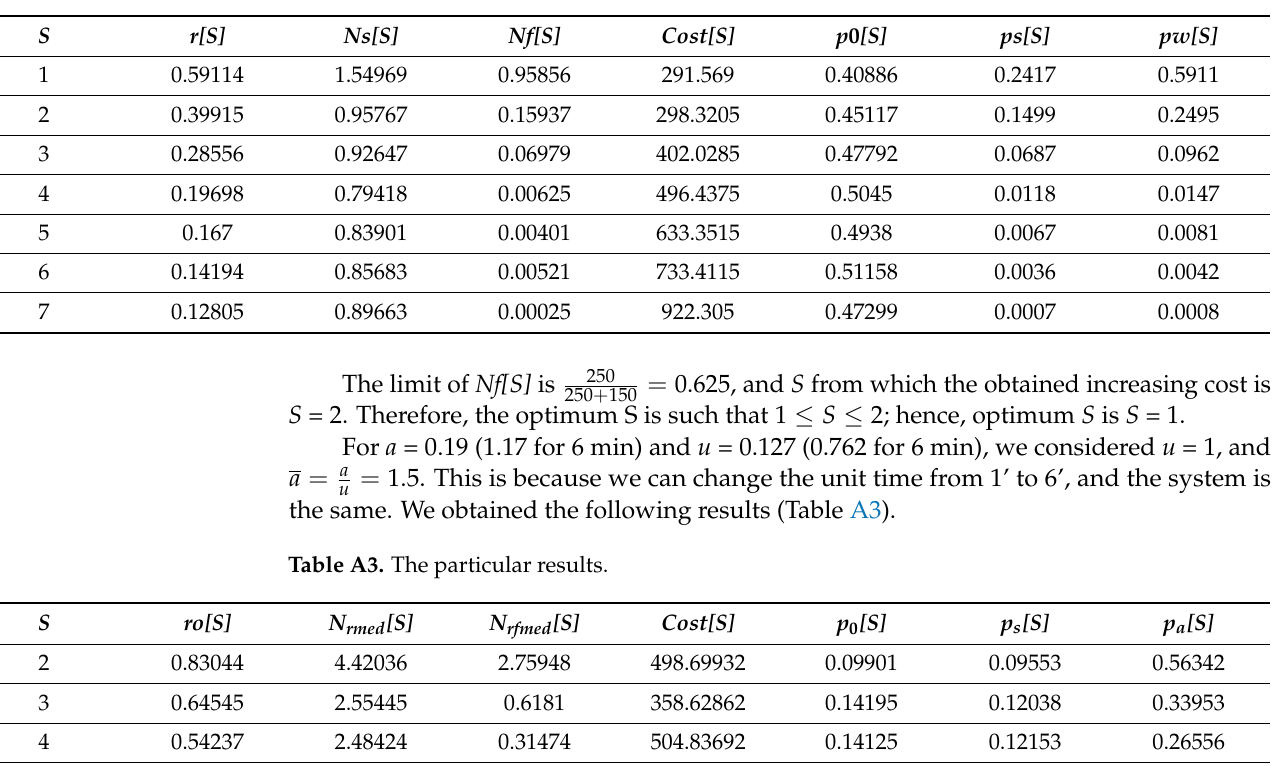
Table A2. The results for a maximum of 7 servers.